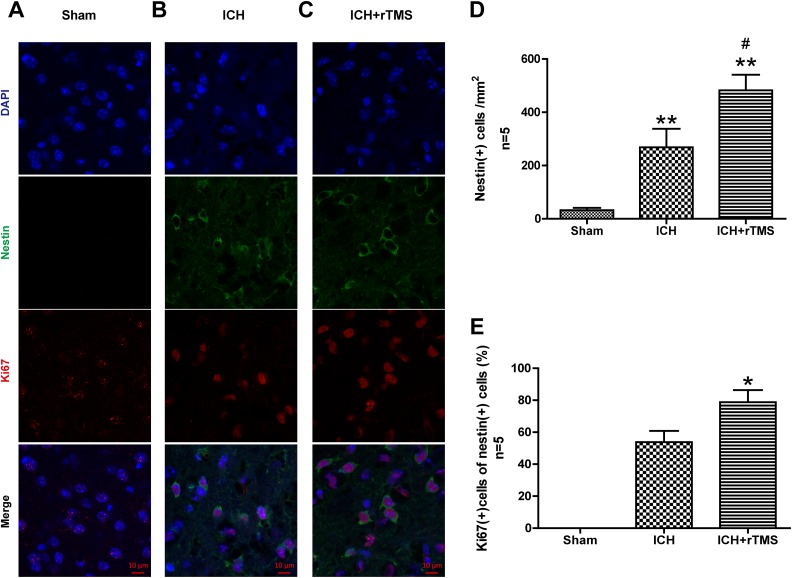
The effects of rTMS on the proliferation of NSCs after ICH. Representative
photographs of immunofluorescence co-staining of NSCs for DAPI (blue), Nestin (green),
and Ki-67 (red) in (A) sham, (B) ICH, and (C) ICH+rTMS groups at 72 h after ICH.
Quantitative analyses of (D) Nestin-positive cells and (E) Ki-67/Nestin
double-positive cells in the sham, ICH, and ICH+rTMS groups at 72 h after ICH.
n = 5 for immunofluorescence staining analysis. Scale bar = 10 μm;
*p < 0.05 vs. sham; **p < 0.01 vs. sham;
#p < 0.05 vs. ICH.